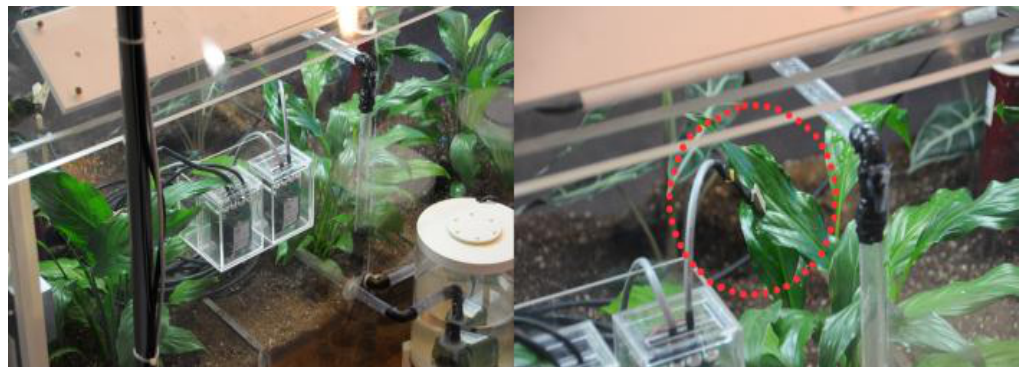
Figure 8. A model greenhouse.